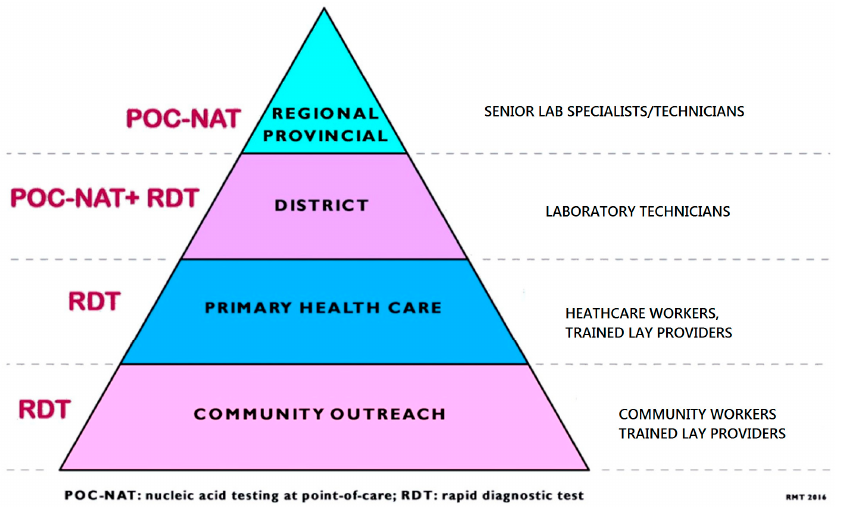
Figure 3. Pyramid of point-of-care diagnostic testing. Adapted from WHO pyramid of laboratory testing [91].